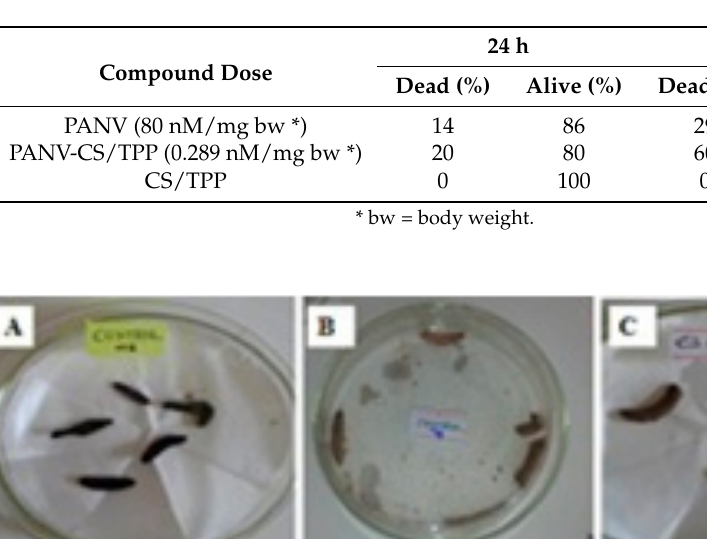
In vivo antimycobacterial activity of Mycobacterium indicus pranii (MIP)-infected Galleria mellonella larvae.